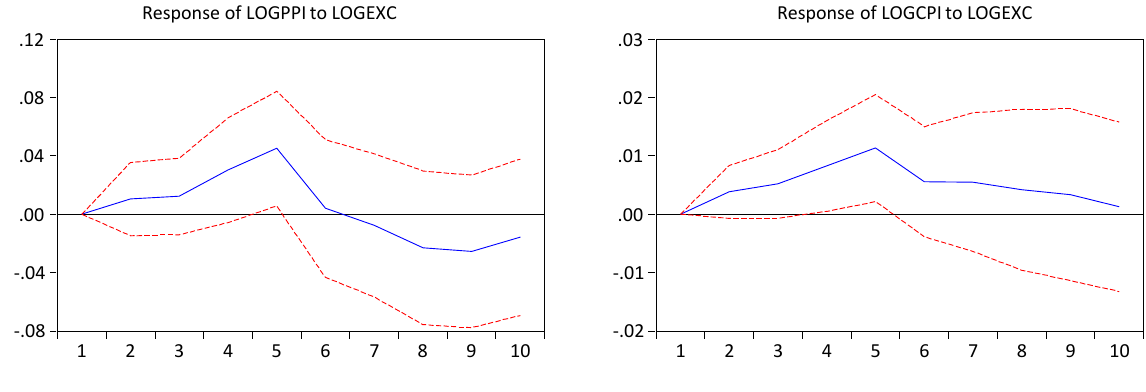
Figure 2. The results of impulse-response